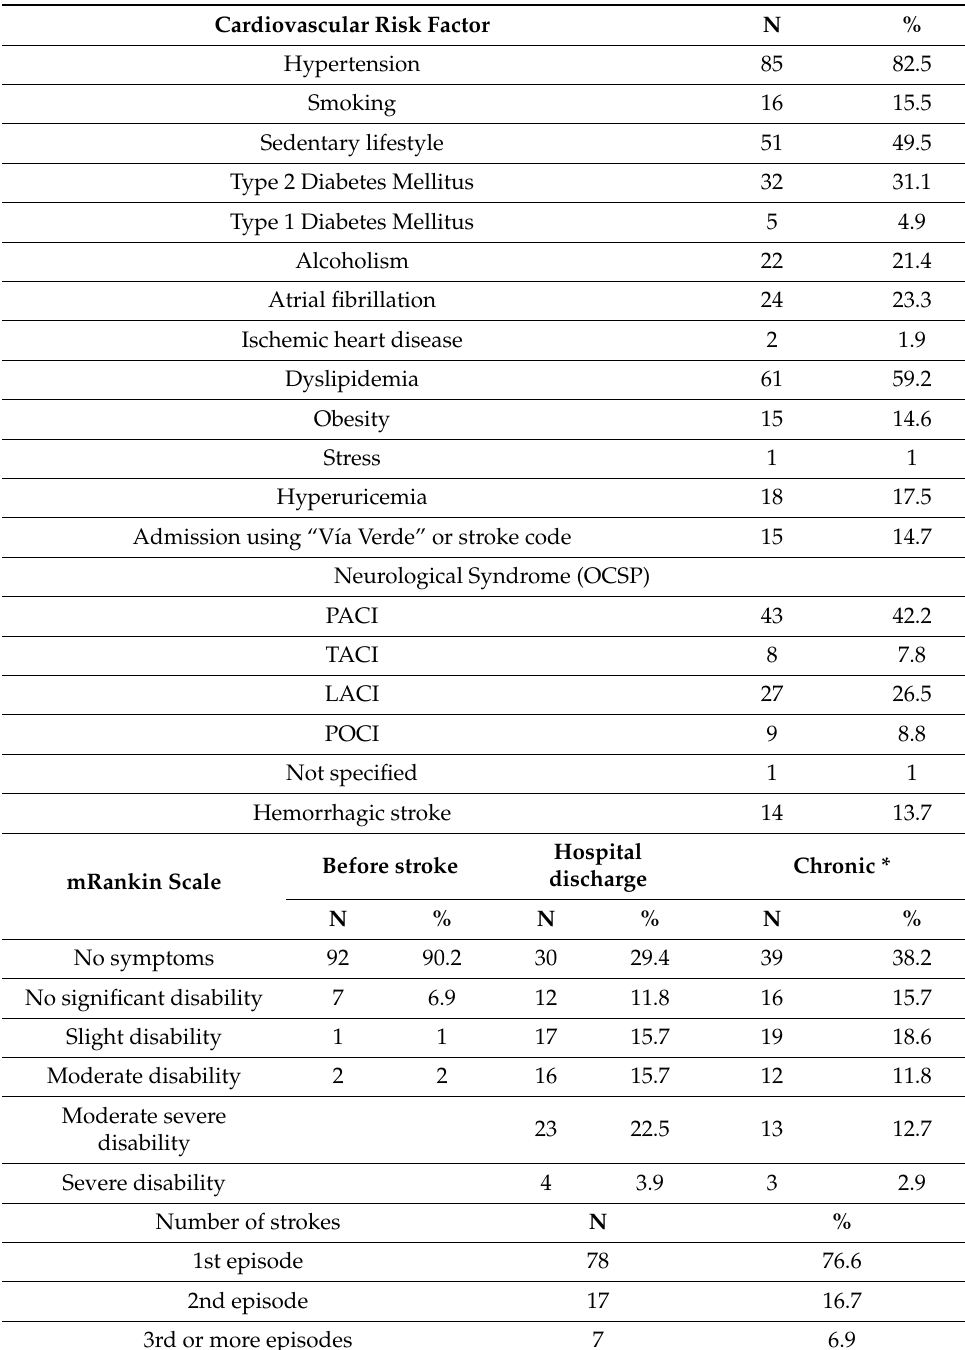
Table 2. Clinical characteristics of the stroke survivors ( n =